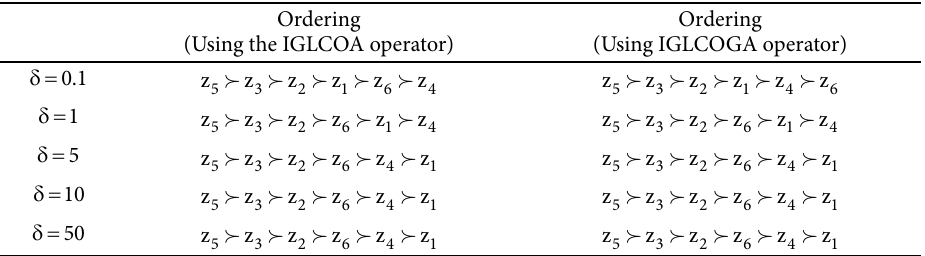
Table 2. Ordering of the alternatives Ordering (Using the IgLCOa operator)